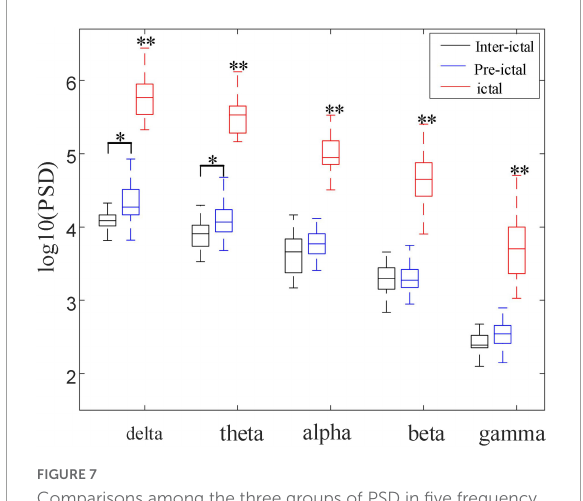
FIGURE7 Comparisons among the three groups of PSD in five frequency bands ( ∗ P < 0.05, ∗∗ P < 0.001). These five frequency bands (delta, theta, alpha, beta, and gamma) in the ictal group were significantly increased compared with pre-ictal and inter-ictal groups, respectively ( H delta = 103.259, H theta = 103.842, H alpha = 100.364, H beta = 101.648, H gamma = 100.785, P < 0.001). Compared with inter-ictal group, delta and theta rhythms were significantly increased in the pre-ictal group ( H delta = 17.132, P = 0.042; H theta = 18.403, P = 0.036) with the degrees of freedom m =